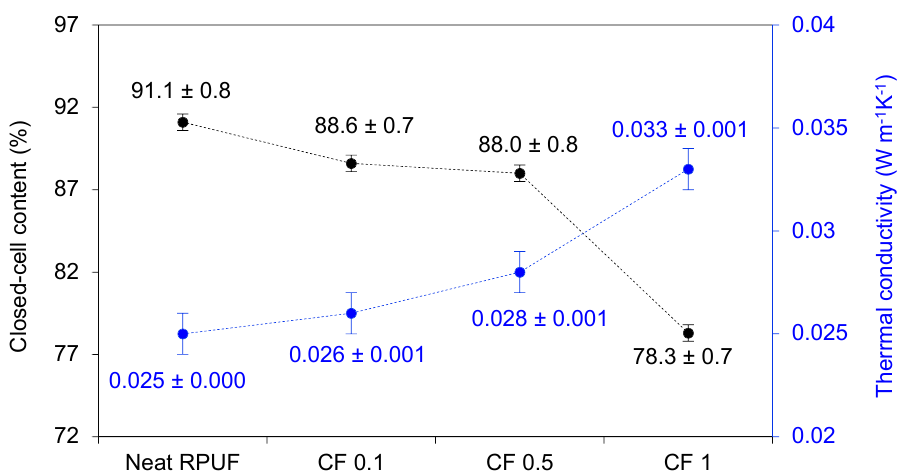
Figure 6. Closed-cell content and thermal conductivity relation for the studied RPUF composites.